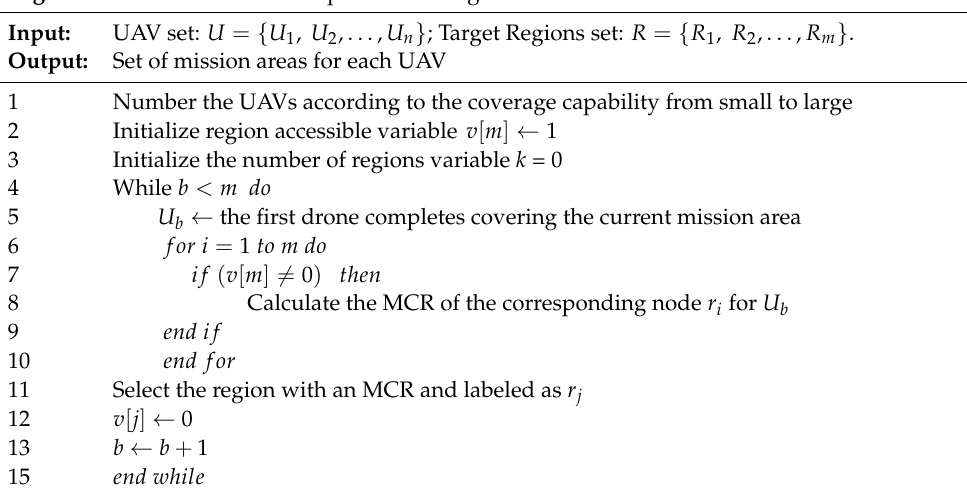
Algorithm 1 Minimum Consumption Ratio